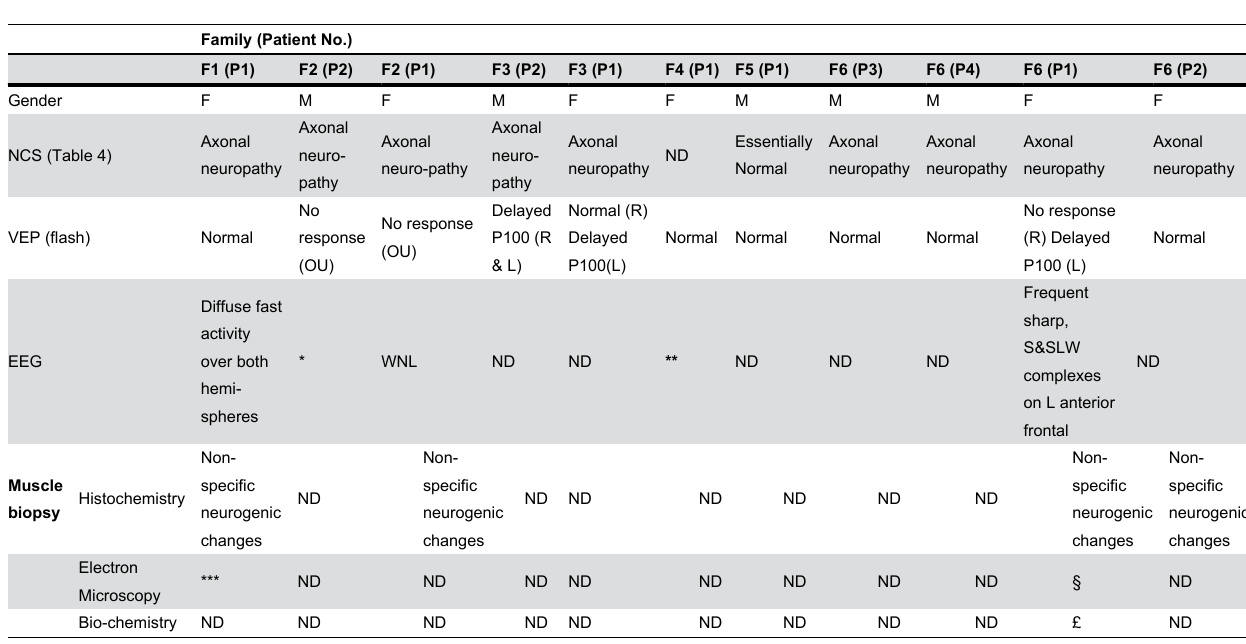
Table 3. Neurophysiological tests and muscle biopsy characterization.